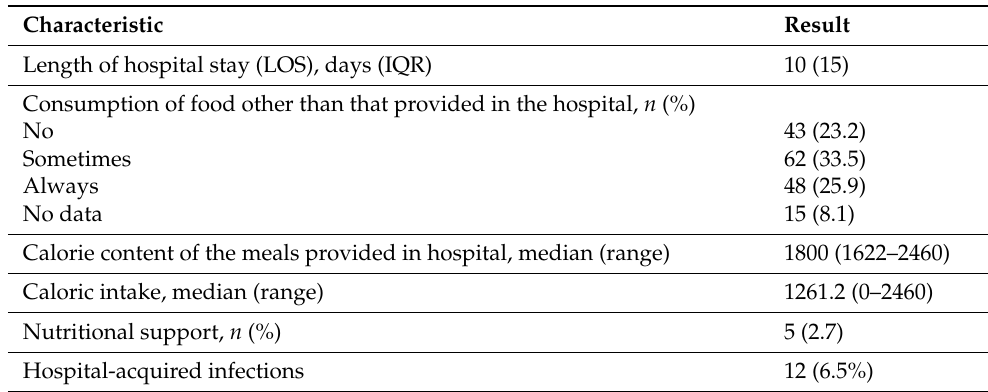
Table 2. Results of the